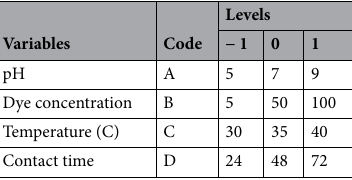
Table 8. The experimental range and levels of input process variables